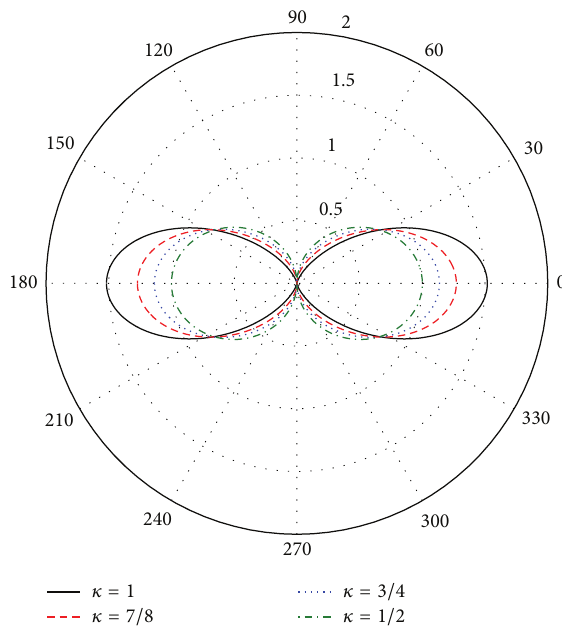
Figure 6: Radiation patterns of the vertical dipole in 2D form.